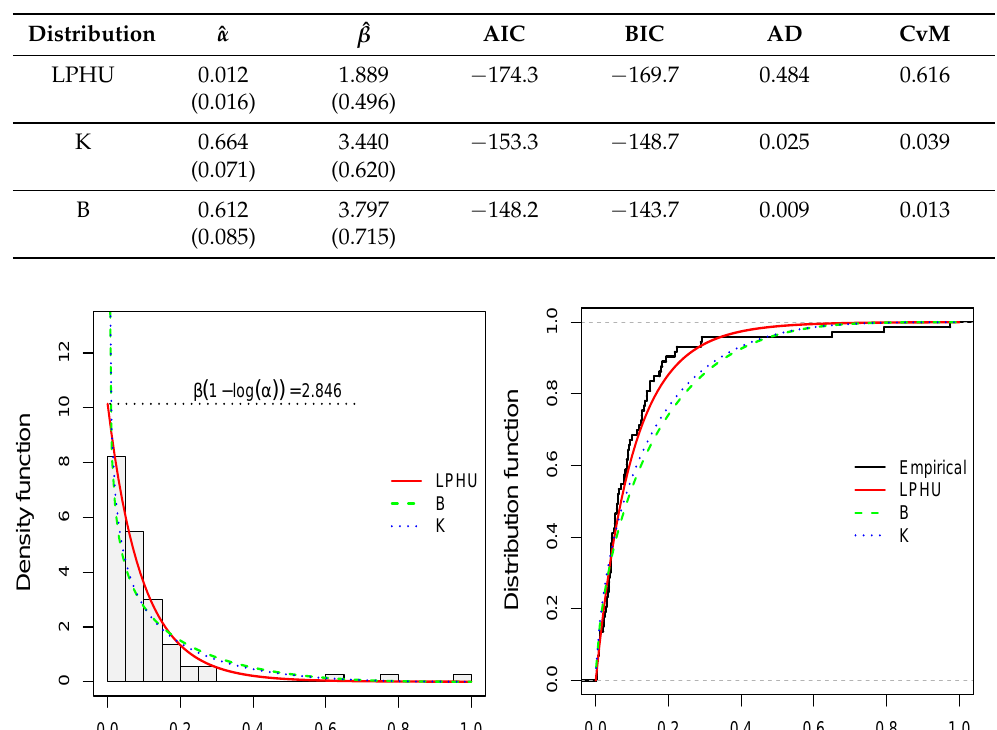
Table 1. The parameter estimates with standard errors in parentheses, the AIC and BIC values, and the p -values of the AD and CvM goodness-of-fit tests for each distribution fitted to the firm’s risk management cost effectiveness data.